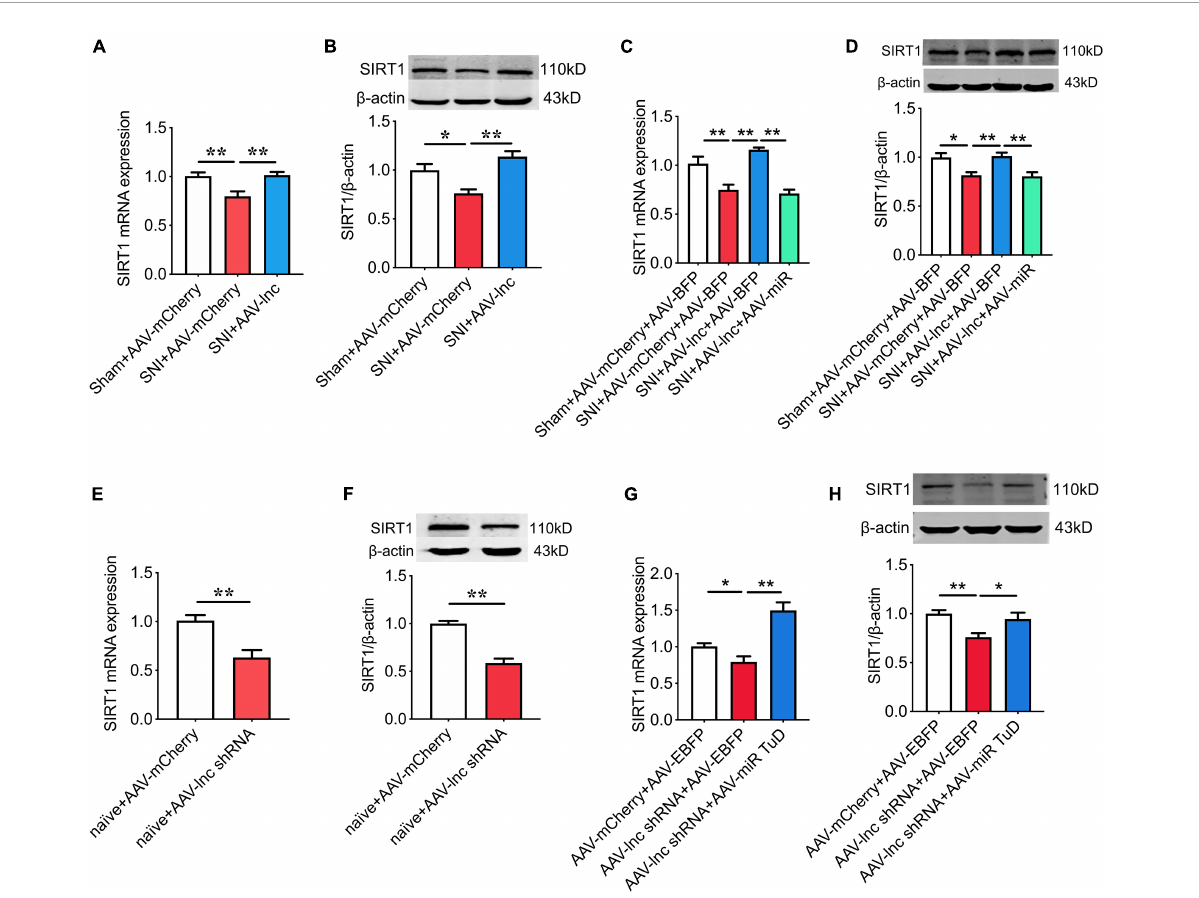
FIGURE7 miR-128-3p is essential for lncRNA-84277 to regulate SIRT1 expression. (A,B) Effect of lncRNA-84277 overexpression on SIRT1 mRNA (A) and protein (B) levels in SNI rats. (C,D) Effect of miR-128-3p overexpression on lncRNA-84277 overexpression-mediated increase of SIRT1 mRNA (C) and protein (D) levels in SNI rats. (E,F) Effect of lncRNA-84277 knockdown on SIRT1 mRNA (E) and protein (F) levels in naïve rats. (G,H) Effect of miR-128-3p knockdown on lncRNA-84277 knockdown-mediated decrease of SIRT1 mRNA (G) and protein (H) levels in naïve rats. All data are expressed as the mean ± SEM. n = 8 for each group. * P < 0.05, ** P <